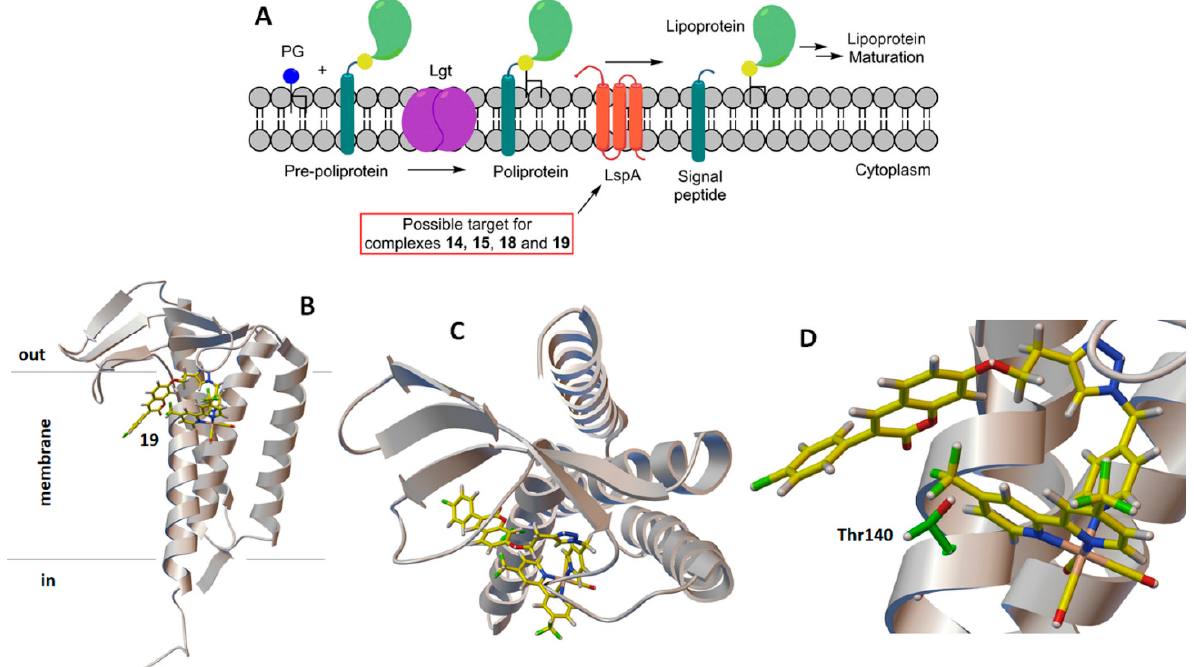
Figure 6. ( A ) Schematic diagram of the lipoprotein post-translational processing pathway with the possible target of the active antimicrobial rhenium complexes. For more details about scheme ( A ), see [73]. Computer-generated lowest energy pose of selected complex 19 in lipoprotein signal peptidase II (LspA): ( B ) side view; ( C ) top view; ( D ) detail of the binding region. In ( C , D ), the amino acid residue most likely involved in the H-bonding interactions with 19 is shown in green.